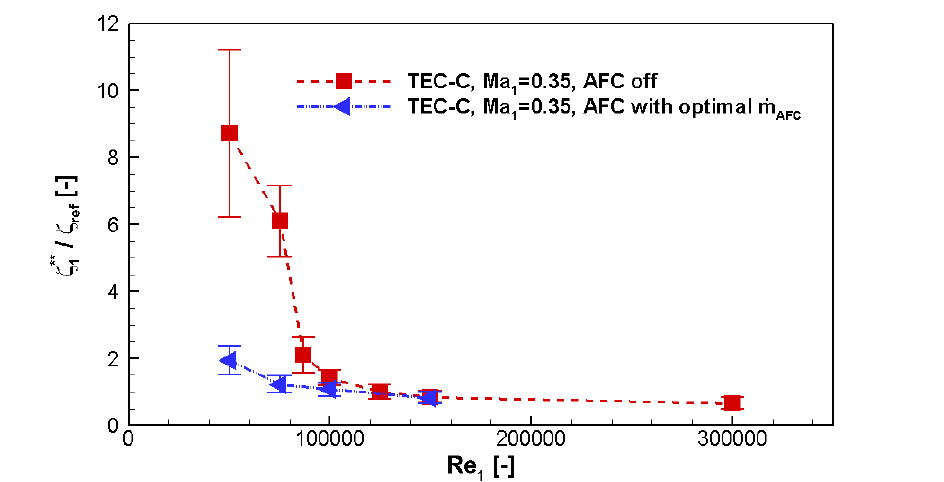
Figure 7. Mass flow corrected integral total pressure loss for different Reynolds